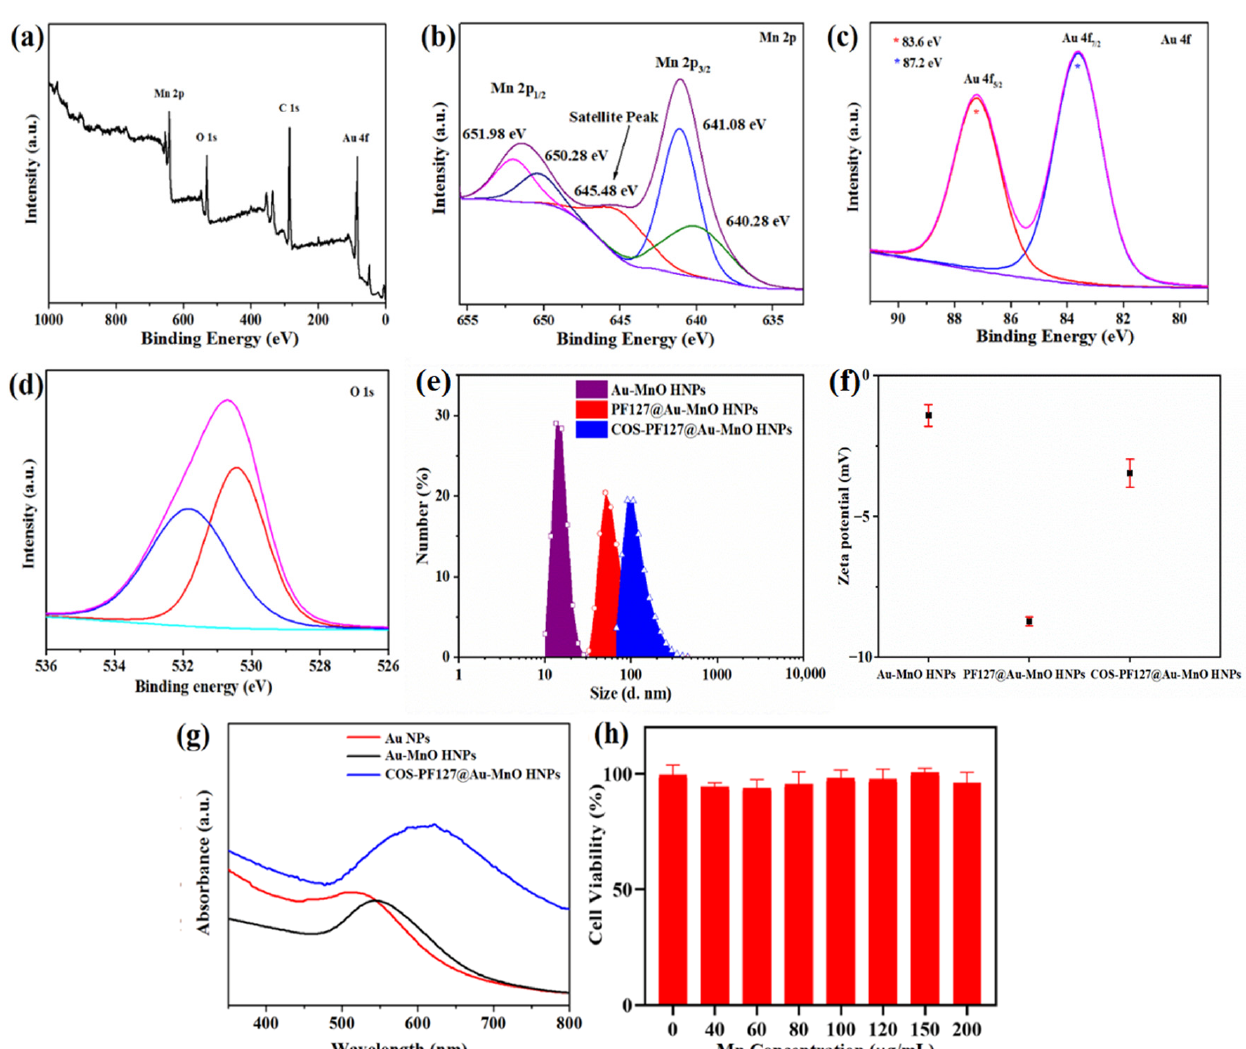
Figure 2. ( a ) XPS of a wide-scan ( b ) high-resolution Mn 2p, ( c ) O1s, and ( d ) Au 4f spectrum of synthesized Au-MnO HNPs. ( e ) Size distribution histogram, ( f ) zeta potential, and ( g ) UV–Vis spectra of fabricated Au-MnO nanocomposites with different coatings. ( h ) Cell cytotoxicity evolution was assessed by MTT assay using various concentrations of COS-PF127@Au-MnO HNPs with respect to